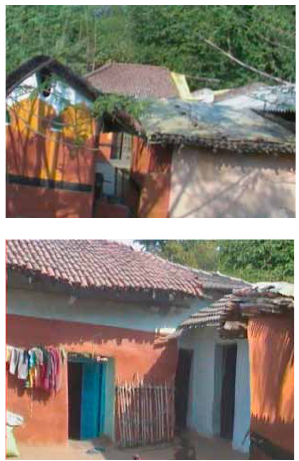
fig. 11. Plus Shaped with central courtyard in the middle